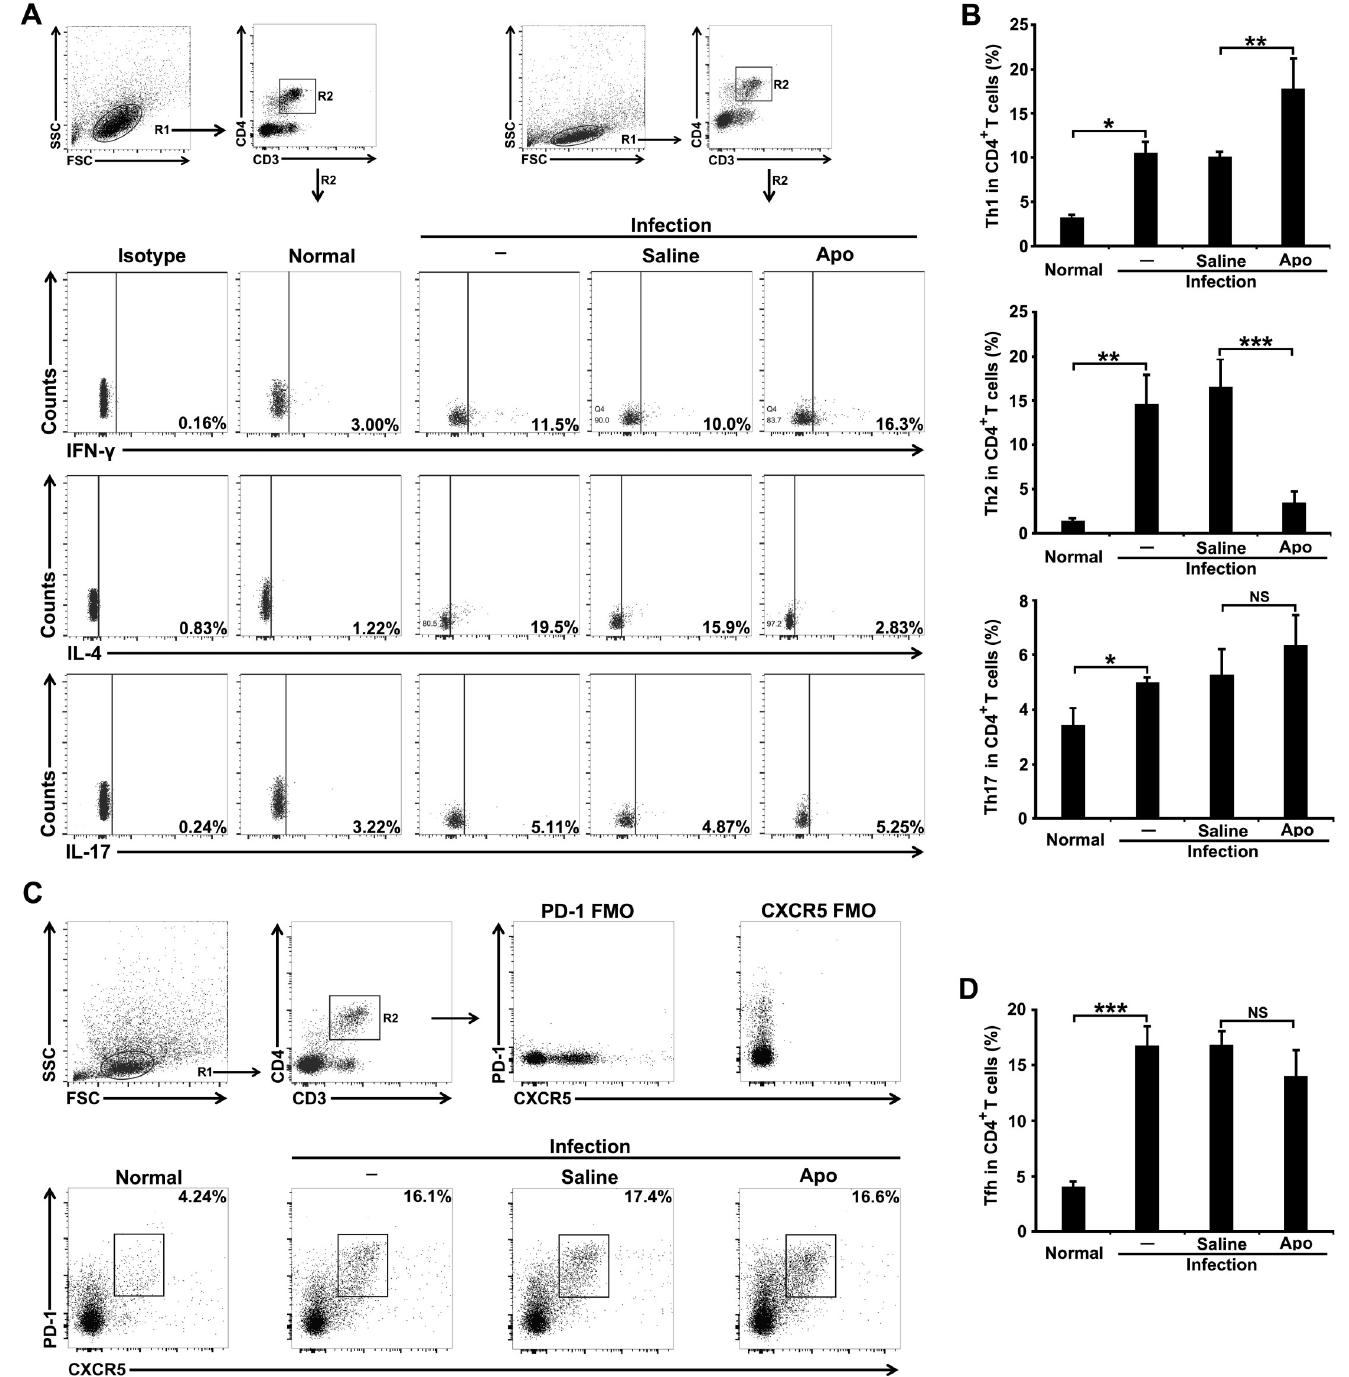
Fig 4. Blocking ROS production shifts from a Th2-type response towards a Th1-type response in S . japonicum -infected mice. S . japonicum -infected mice were untreated (-) or treated with saline or Apo orally. Normal, uninfected mice left untreated. (A and B) FCM gating strategies show total lymphocytes (R1) and CD3 + CD4 + T cells (R2). Representative FCM dot plots show IFN- γ -(Th1), IL-4-(Th2), and IL-17-(Th17) producing CD3 + CD4 + T cells from the livers of mice of each group (A). The bar graphs show the average percentages for Th1, Th2, and Th17 cells (B). (C and D) Representative FCM dot plots show CD3 + CD4 + CXCR5 + PD-1 + Tfh cells from livers of mice of each group (C). The bar graphs show the average percentages for Tfh cells (D). Data are expressed as the means ± SD of four mice per group and representative of three independent experiments. � P < 0.05, �� P < 0.01, ��� P < 0.001. NS indicating not significant.